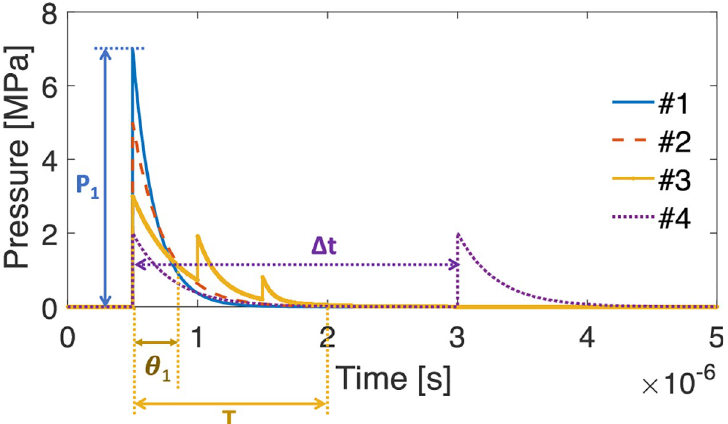
Fig 1. Four different shock wave profiles that produce the same impulse. P 1 is the peak pressure. θ 1 is the decay time of the first peak. T is the total duration of the shock waves. Δ t is the time gap between two sequential shock waves. The area under the shock wave curve represents the